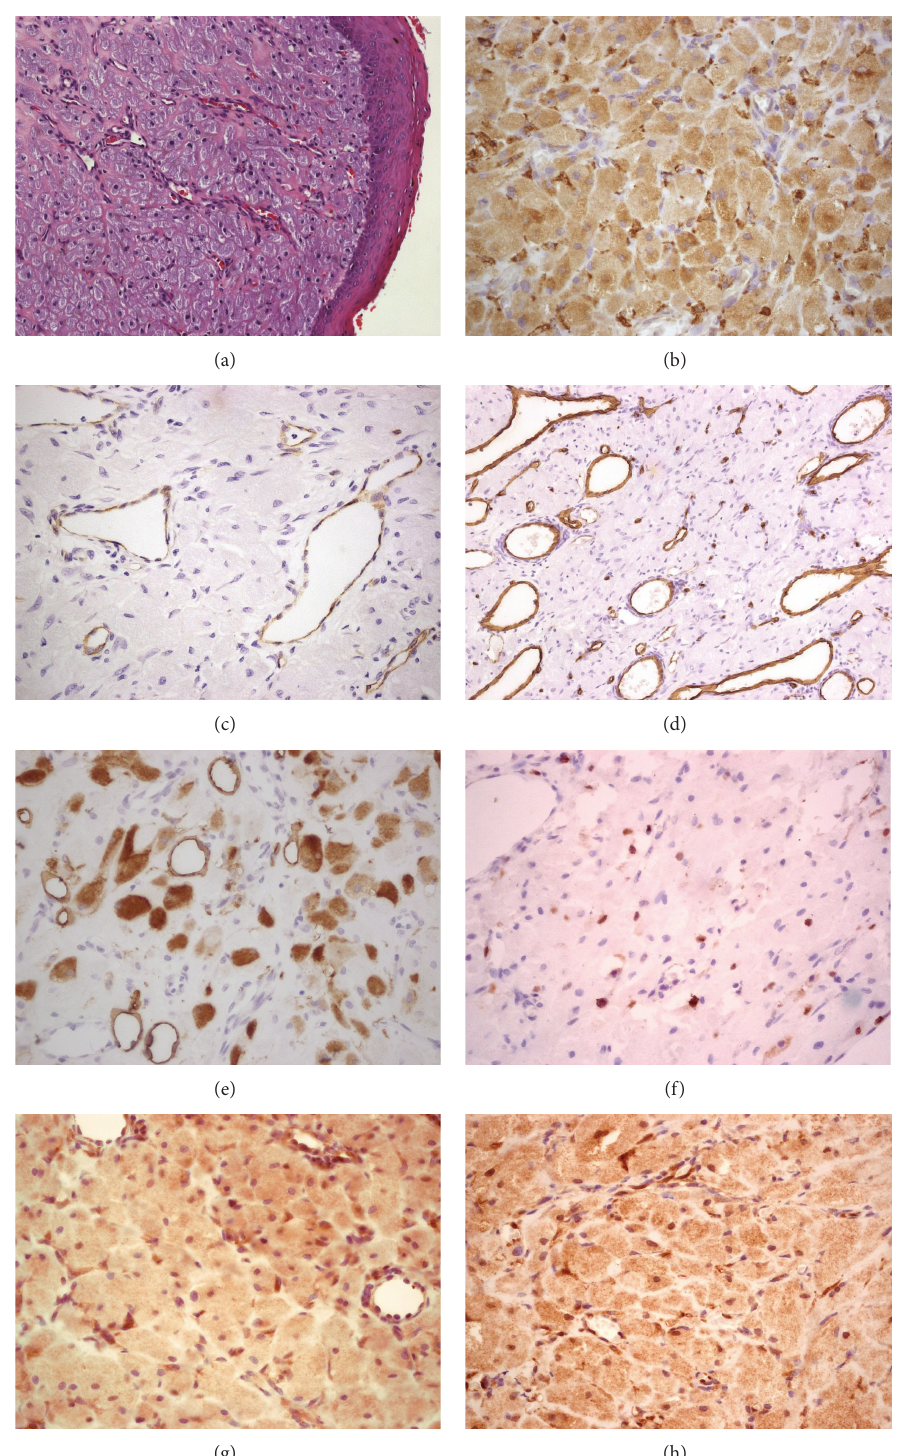
Figure 2: Histological and immunohistochemical sections. (a) Large round granular cells with an abundant eosinophilic cytoplasm and basophilic nuclei in a background of prominent vasculature and lined by an atrophic epithelium (H&E 200x). (b) Granular cells demonstrating strong positivity for CD68 (400x). ((c) and (d)) Endothelial cells positive for CD105 and CD34, respectively. (e) D2-40 positive immunostaining for granular cells and lymphatic vessels. (f) Weak staining for Ki67, showing a low grade of proliferation. ((g) and (h)) Overexpression of VEGF and FGF in granular cells and endothelial cells,